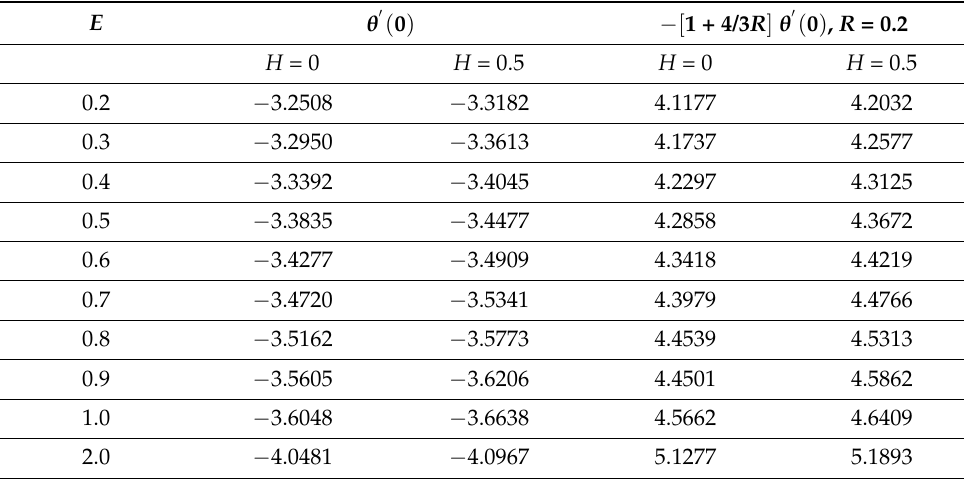
Table 18. Impact of Eckert number on Nusselt number with and without heat